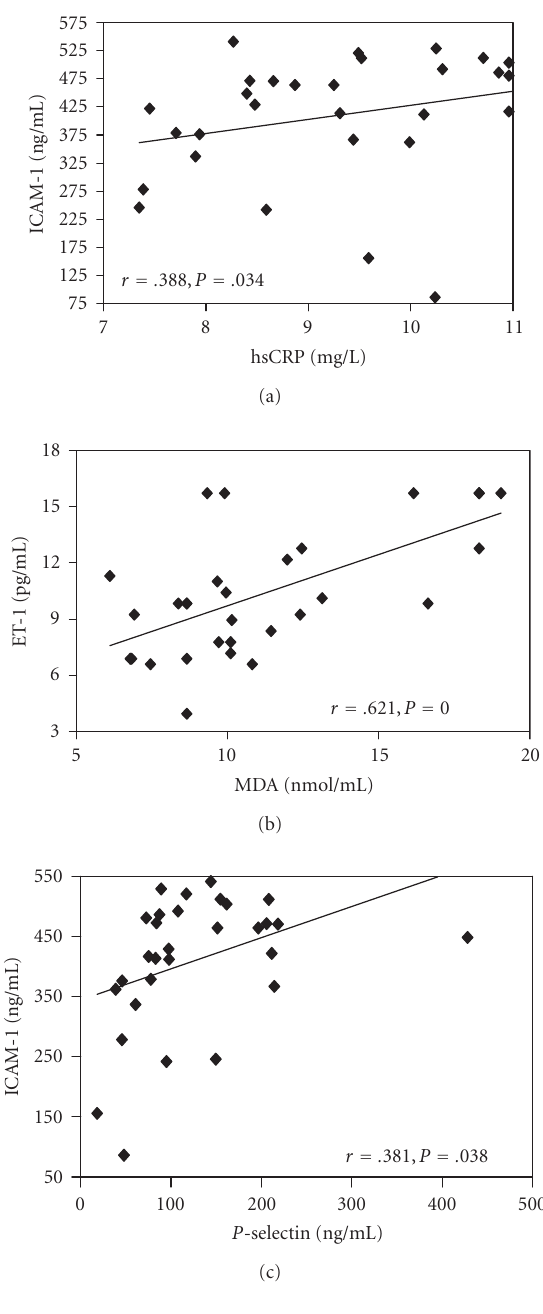
Figure 2: Correlation between (a) MDA (nmol/mL) and ET-1 (pg/mL), (b) hsCRP (mg/L) and ICAM-1 (ng/mL), (c) P -selectin (ng/ml) and ICAM-1 (ng/mL) in type 2 DM patients (groups III and IV) ( n = 30). Each individual value is represented by a symbol ( (cid:2) ), r = Spearman’s rank correlation coe ffi